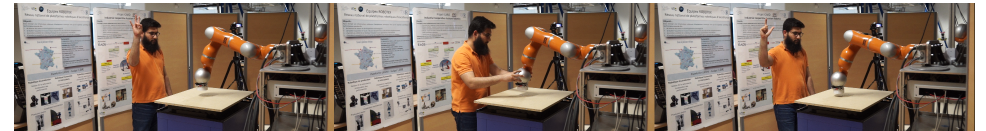
Figure 10. Snapshots of our gesture-controlled safe human-robot interaction experiment taken from [11] with the authors’ permission. The human operator manually guides the robot to way- points in the workspace then asks the robot to record them through a gesture. The human operator can transmit other commands to the robot like replay, stop, resume, reteach, and so forth with only hand